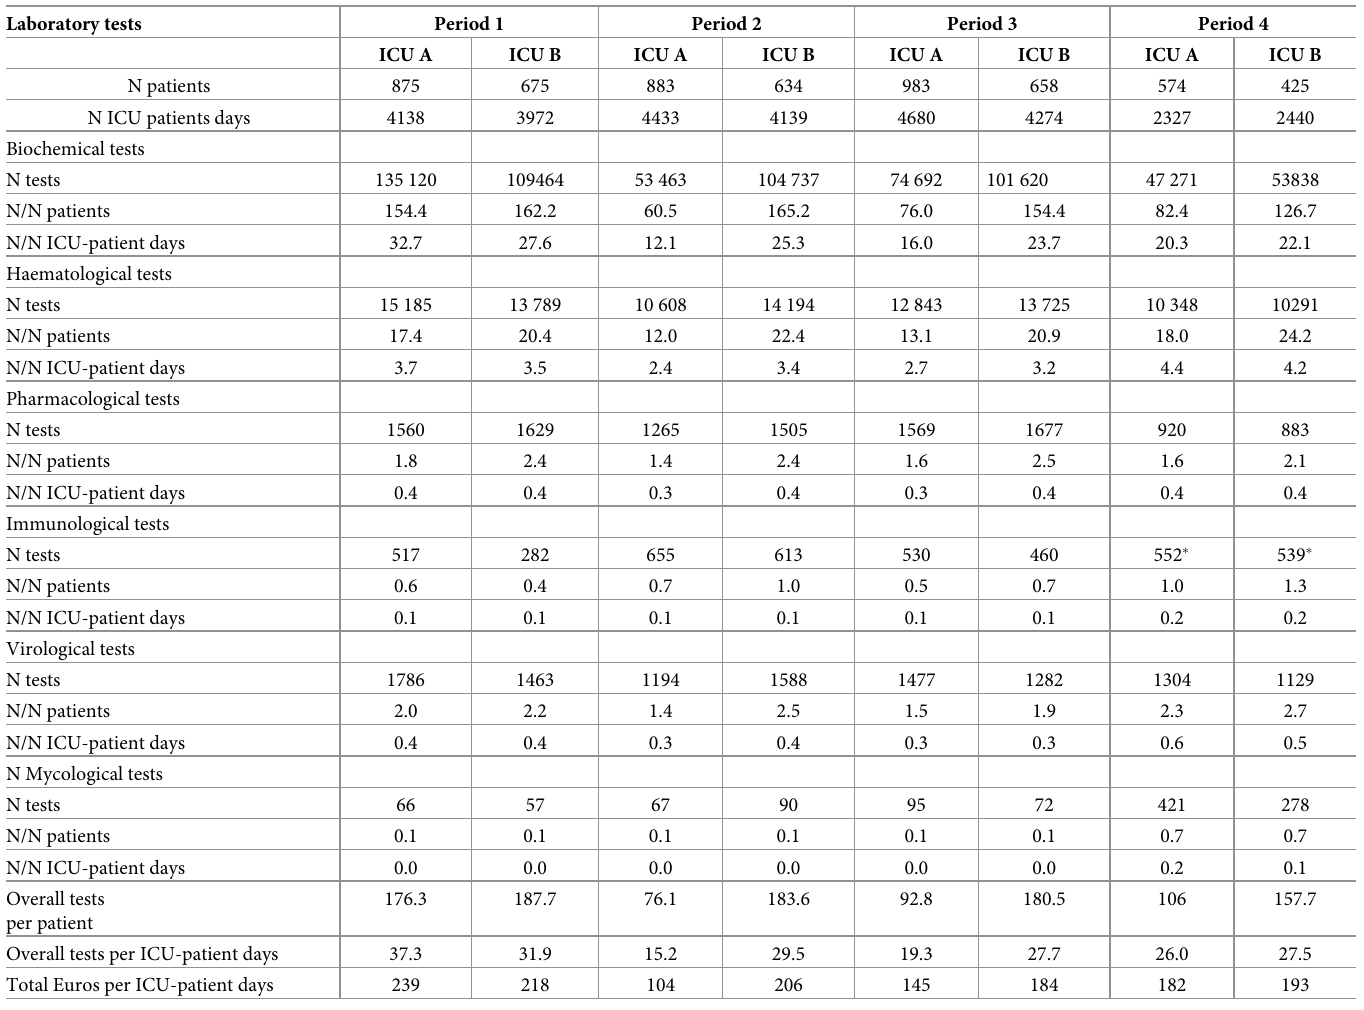
Table 6. Comparison of laboratory test orders between ICU A and B according to different periods 1